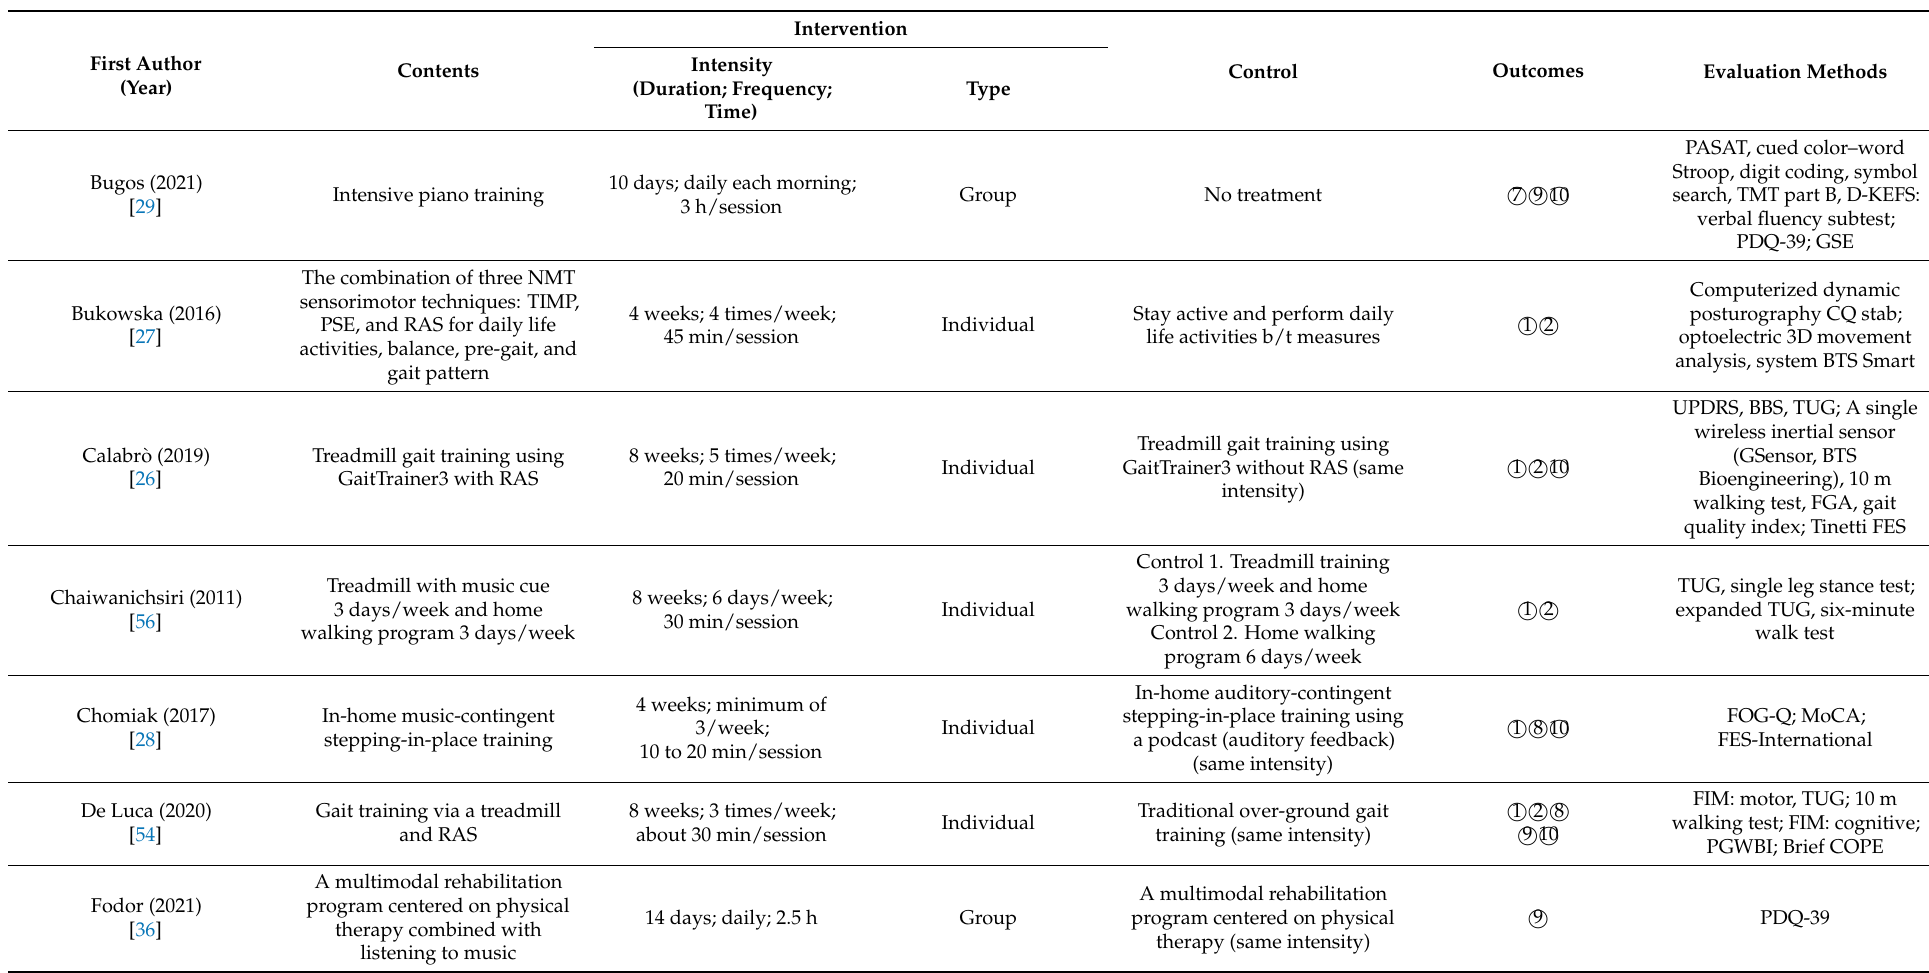
Table 2. Characteristics of